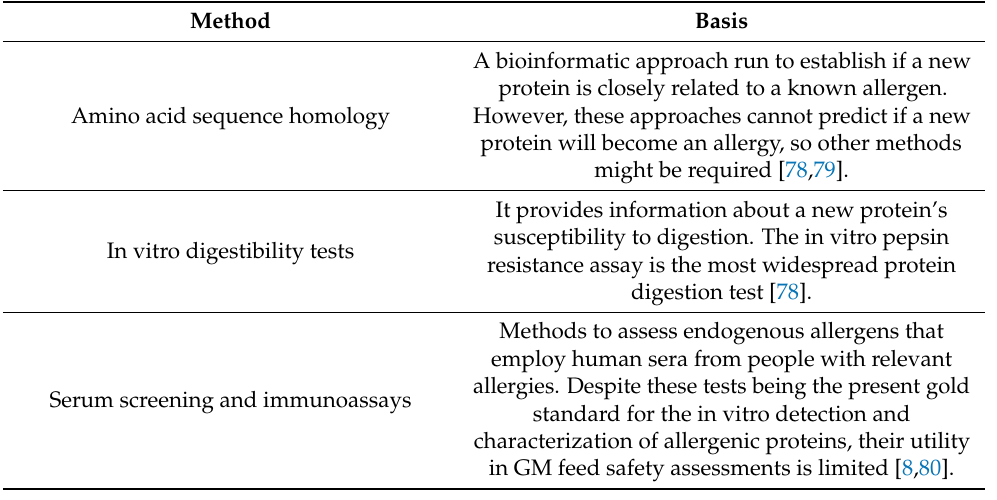
Table 2. Some of the most popular methods for determining